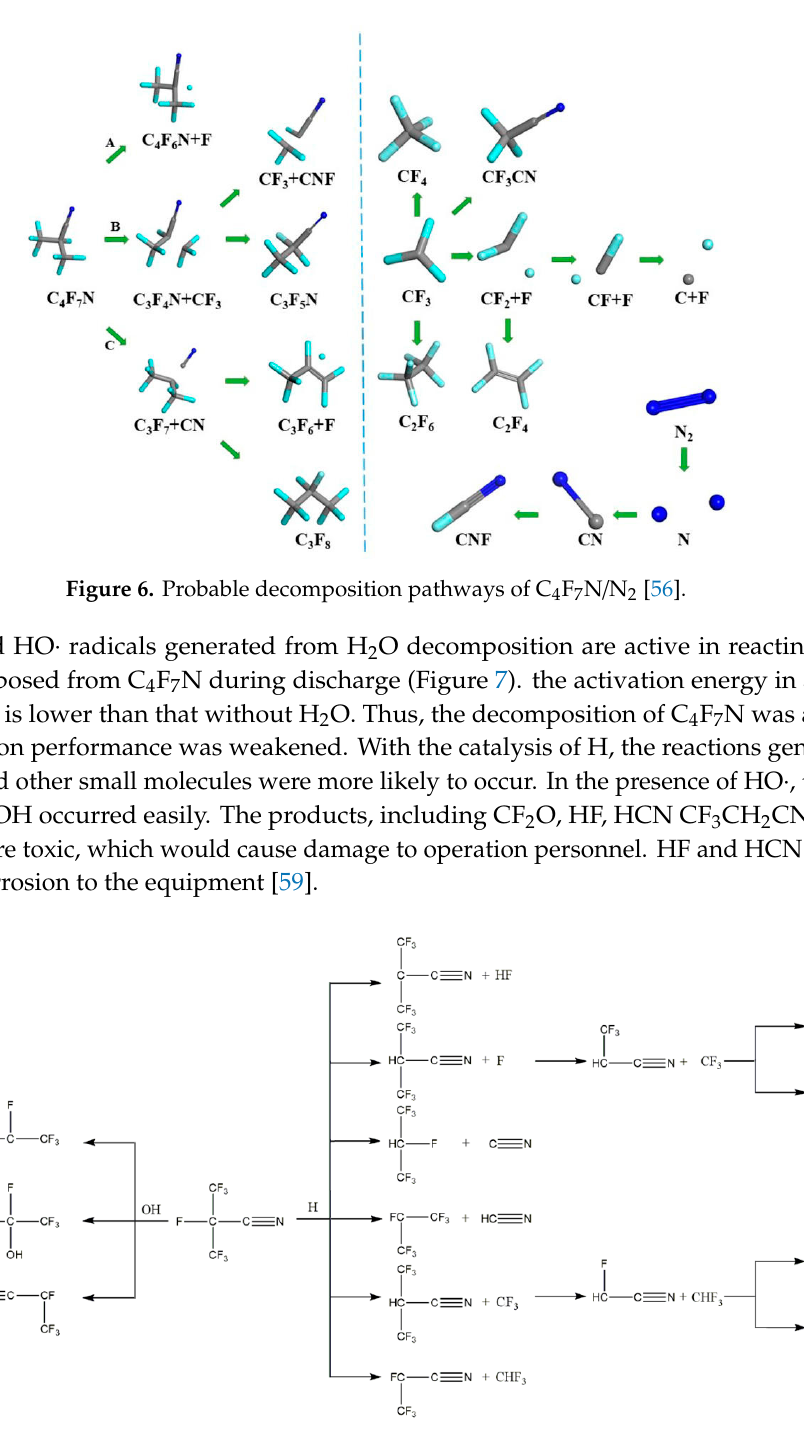
Figure 7. Decomposition pathways of C 4 F 7 N in the presence of H 2 O.